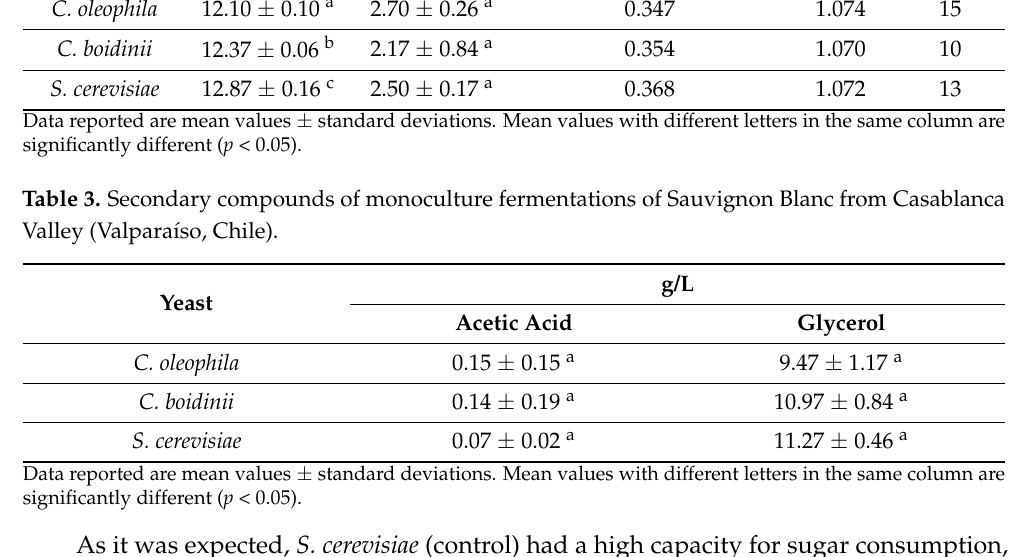
Table 2. Monoculture fermentations of Sauvignon Blanc from Casablanca Valley (Valpara í so, Chile). Ethanol Yeast